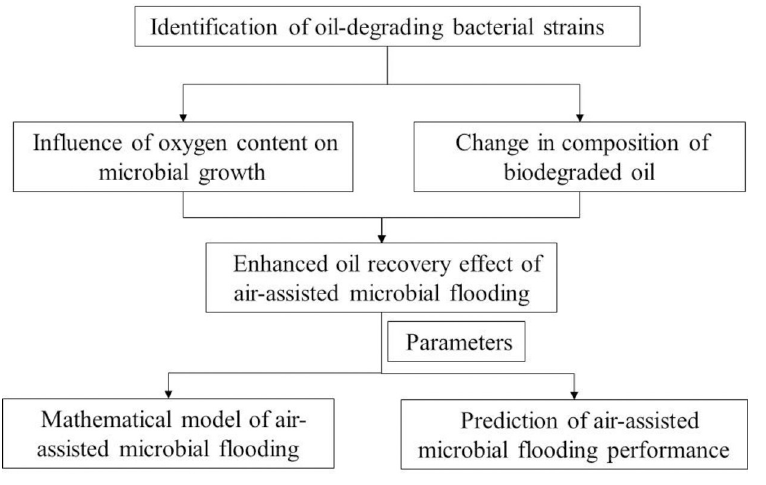
Fig 1. The general sketch of this study.